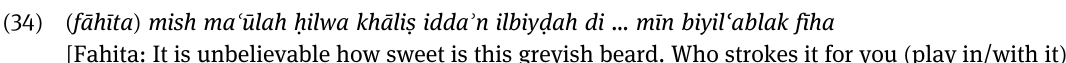
[ Fahita: It is unbelievable how sweet is this greyish beard. Who strokes it for you ( play in/with it ) ?